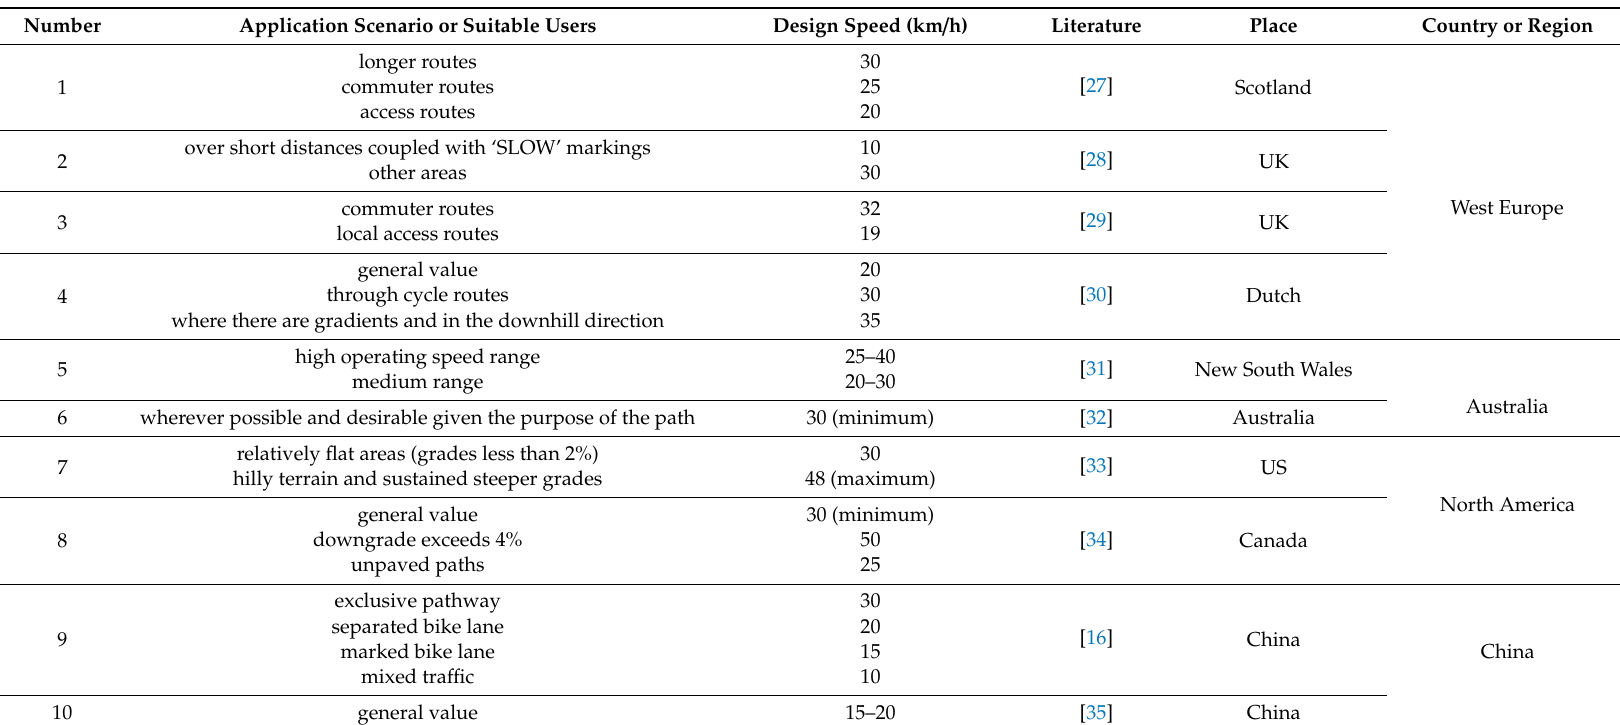
Table 2. Design Speed of Bicycles Facility from Previous